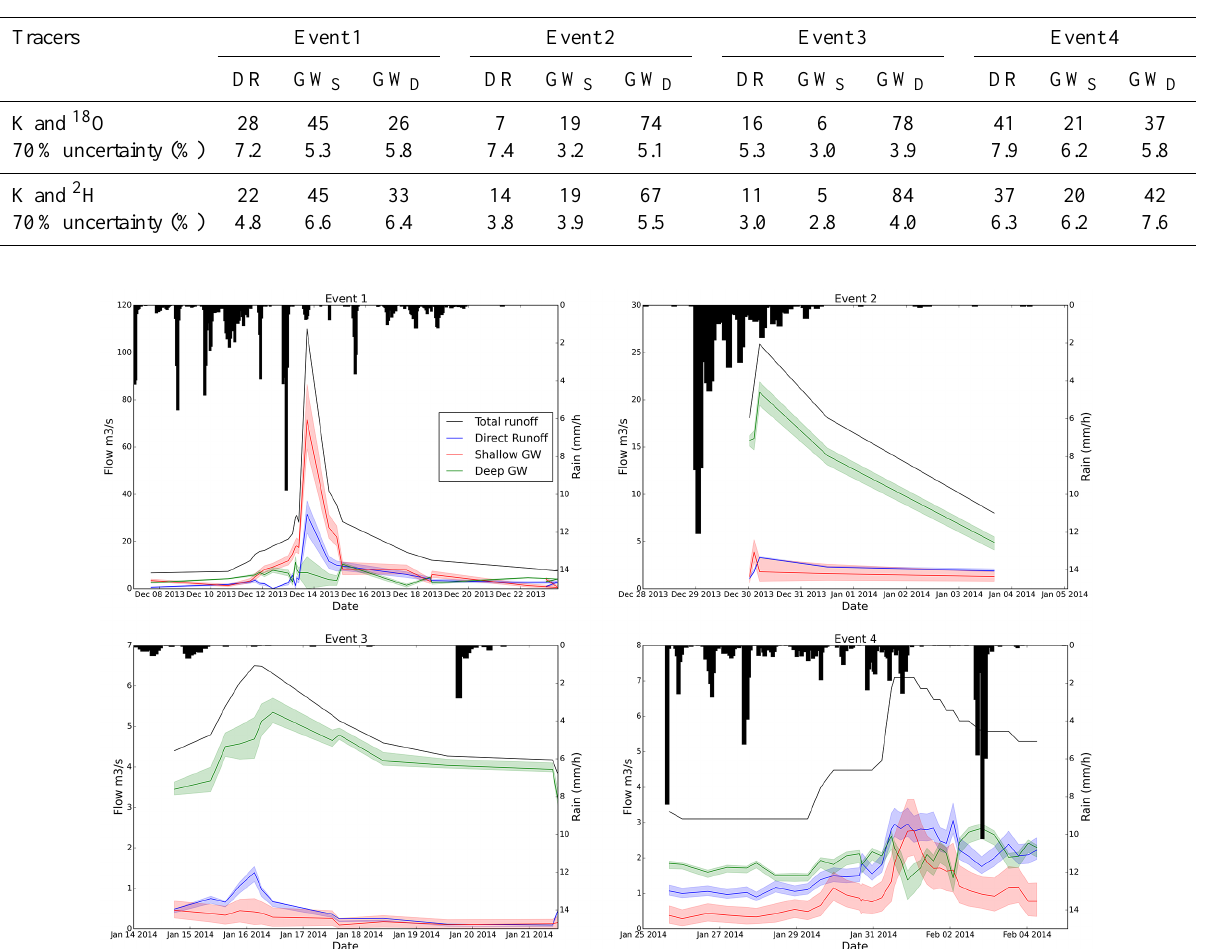
Figure 12. Three-component hydrograph separations using K and 2